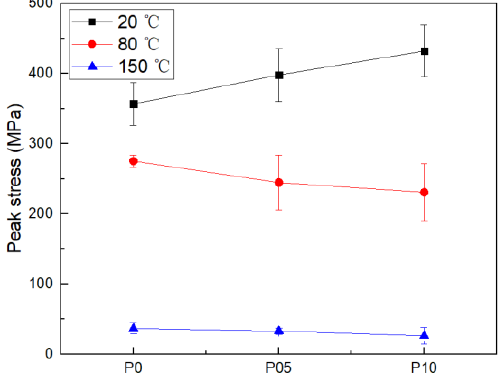
Figure 10. Peak stress of phenolic modified PWLC.